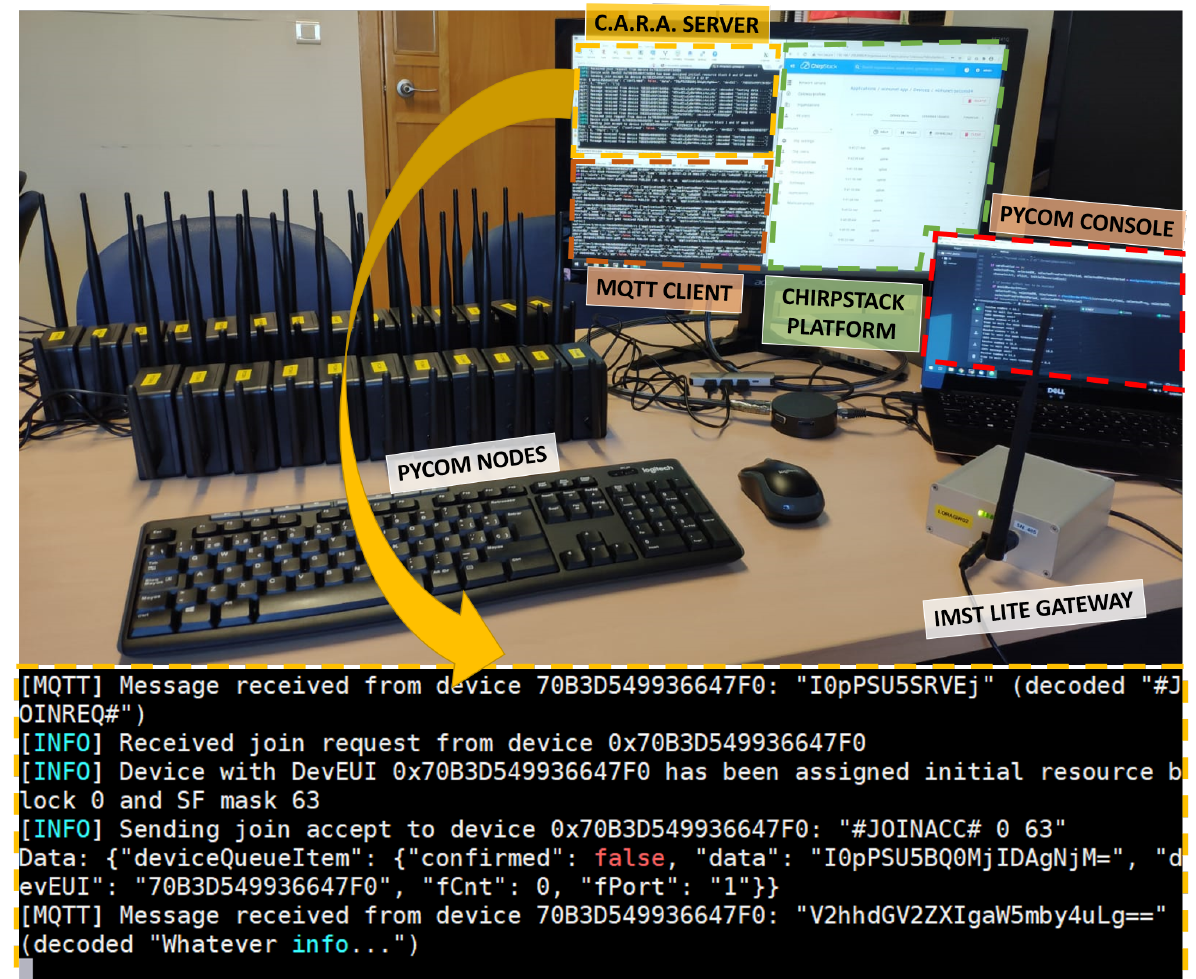
Figure 14. Testbed with our CARA